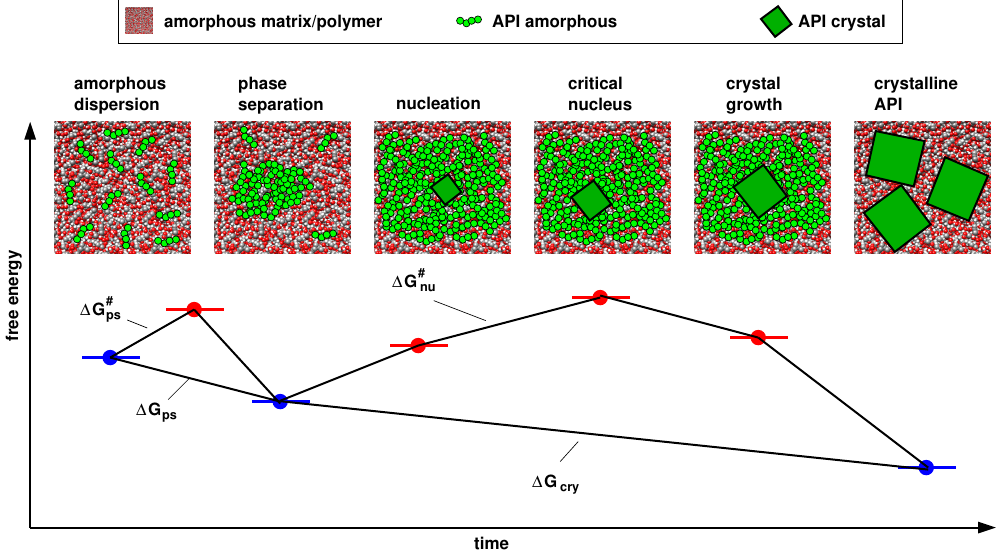
Figure 1. Schematic presentation of the free energy landscape of an amorphous solid dispersion undergoing molecular relaxation, phase separation, nucleation and crystal growth.